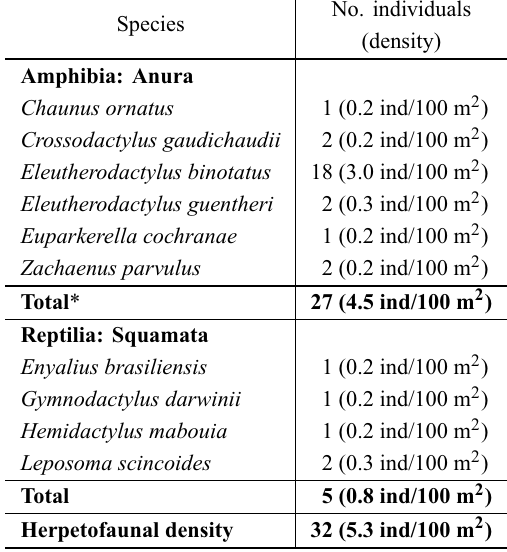
Total number of individuals sampled and estimated density (individuals/100 m 2 , in parentheses) of each amphibian and reptile species found in the Atlantic rainforest of Morro São João, in southeastern Brazil, using 5 × 5 plot sampling